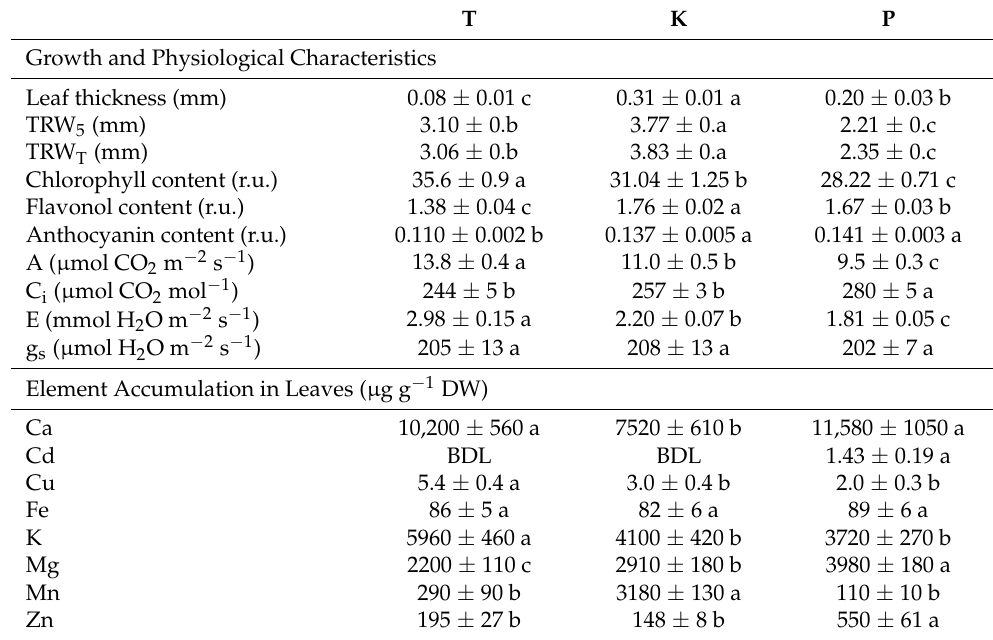
Table 1. Plant growth, gas exchange, pigment content and element accumulation in leaves. T K P Growth and Physiological